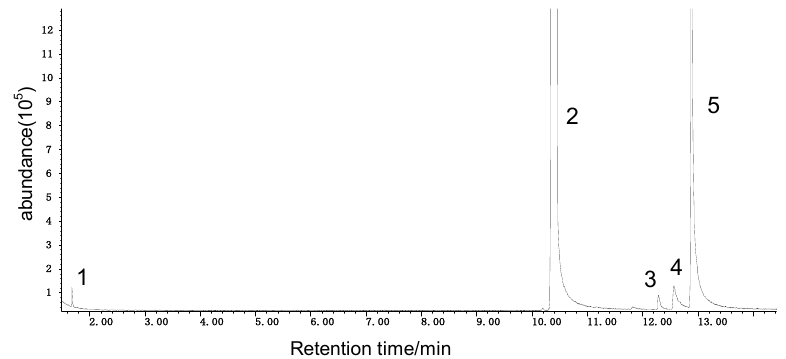
Figure 3. GC-MS of the oxidation products of diphenyl sulfide.